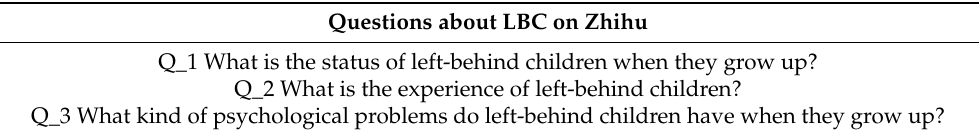
Table 1. The three most popular questions posted about LBC on the Zhihu website. Questions about LBC on